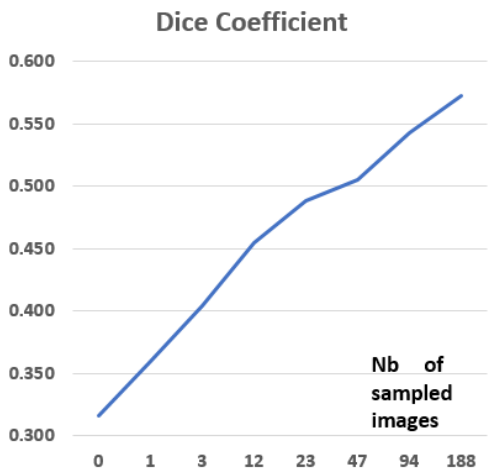
Figure 15. Segmentation dice coefficient for different numbers of sampled images from the target